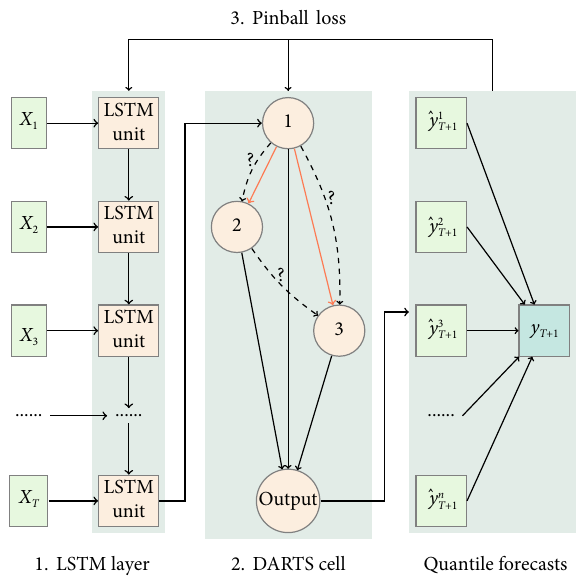
Fig. 2 Overall model